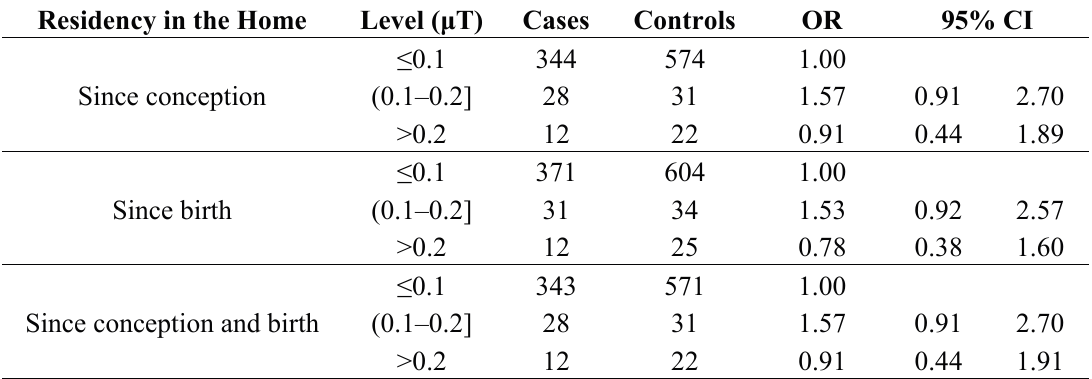
Table 7. Sensitivity analyses—Further restriction on the house: ORs for childhood leukemia (all types), according to ELF-MF exposure (arithmetic mean of 24–48 h bedroom measurements) in the subset of children still living in the dwelling inhabited since conception and/or birth (unconditional logistic regression models ULR-2, adjusted for age, sex, region, and parents’ educational